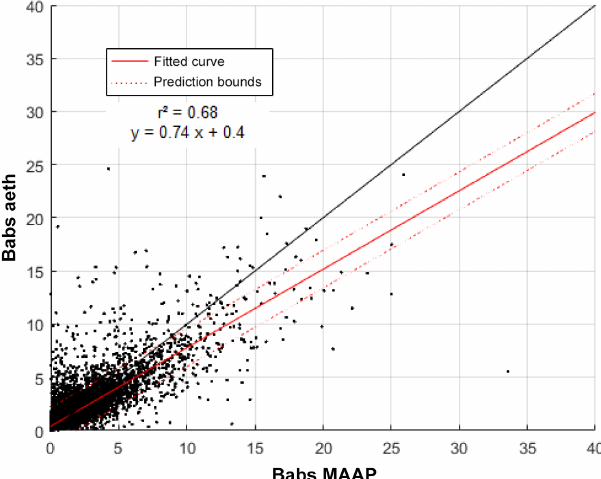
Figure A3. Comparison of absorption coefficients (babs) measured at 635nm according to aethalometer and MAAP measurements from the CHC dataset between 2012 and 2014. Black line corre- sponds to the 1-to-1